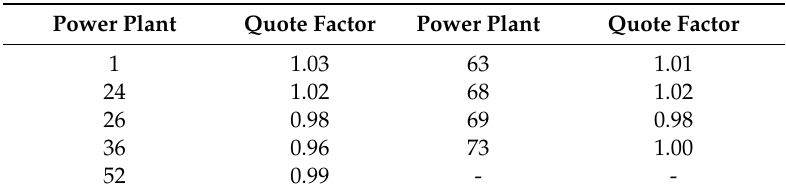
Table 2. Power plant bidding parameters.